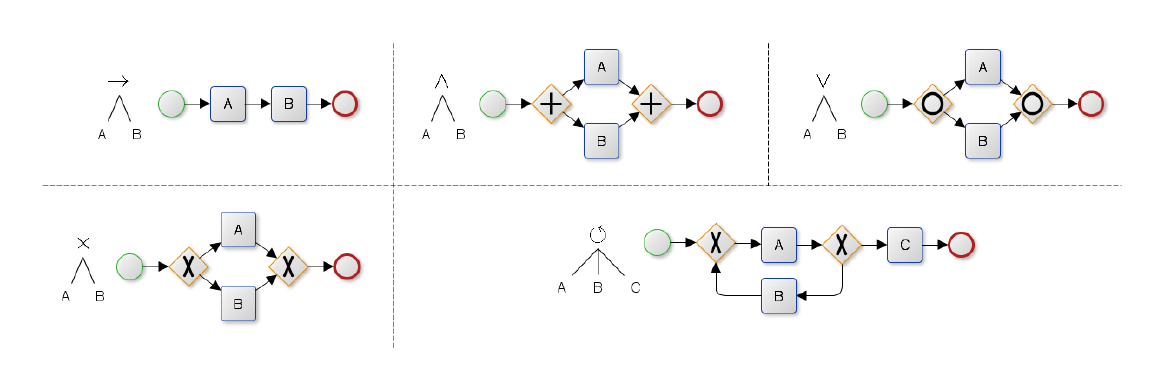
Figure 2. The process tree operators and their relation to BPMN constructs